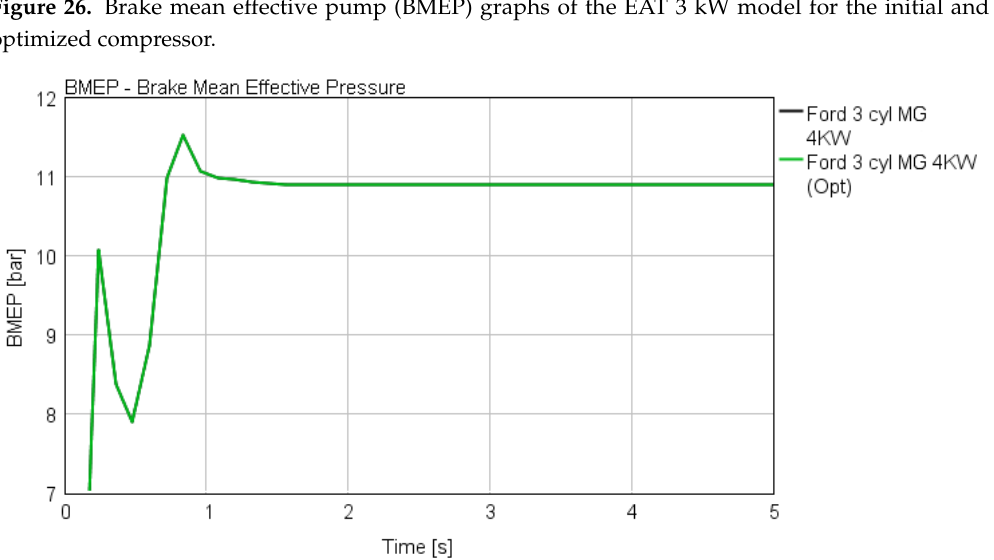
Figure 27. Brake mean effective pressure (BMEP) graphs of the EAT 4 kW model for the initial and optimized compressor.